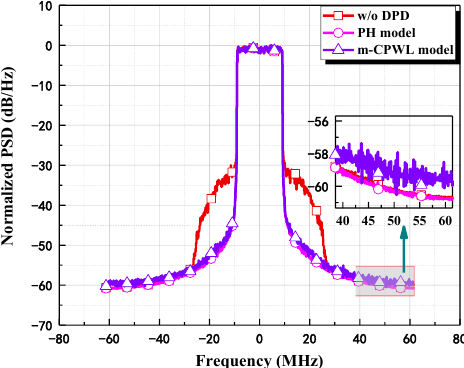
Figure 3. Block diagram of the proposed DPD solution.